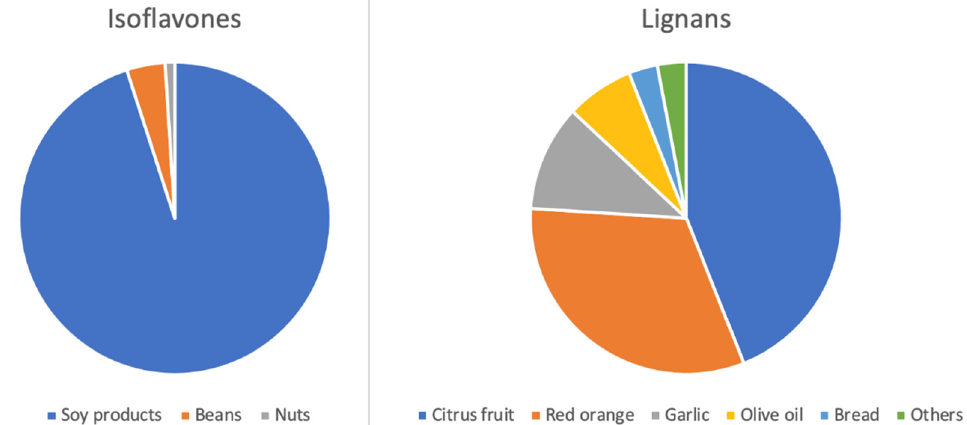
Figure 1. Major food sources of phytoestrogens in the study sample ( n = 883).